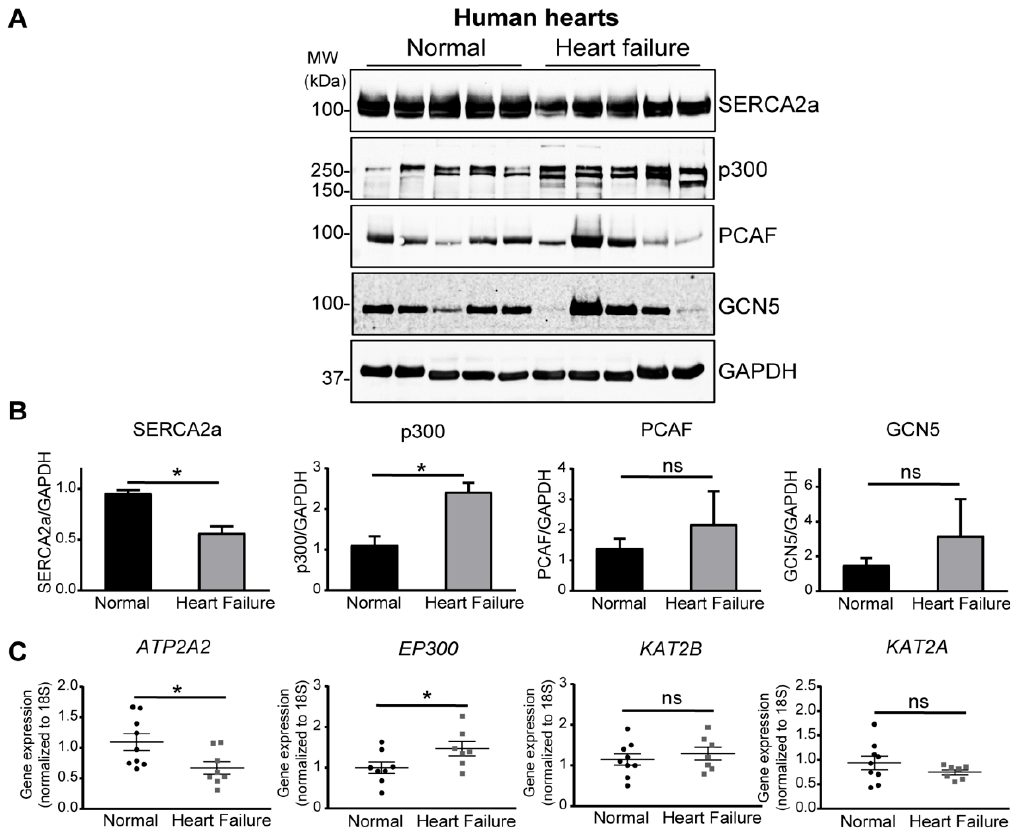
Figure 1. p300 is increased in human heart failure. ( A ) Heart biopsy samples from patients with heart failure and normal controls were homogenized and immunoblotted with the indicated antibodies. Representative immunoblots of SERCA2a and key acetyltransferases (p300, PCAF, GCN5) in heart biopsies from normal and heart failure individuals are shown. ( B ) Quantification plots of immunoblot data. ( C ) mRNA levels of SERCA2a and key acetyltransferases (p300, KAT2A, KAT2B) in heart biopsies from normal and heart failure individuals. Data are represented as the mean ± SD. Donors, n = 9; failing patients, n = 8. ns, not significant; * p < 0.05 vs. normal by unpaired t -test.